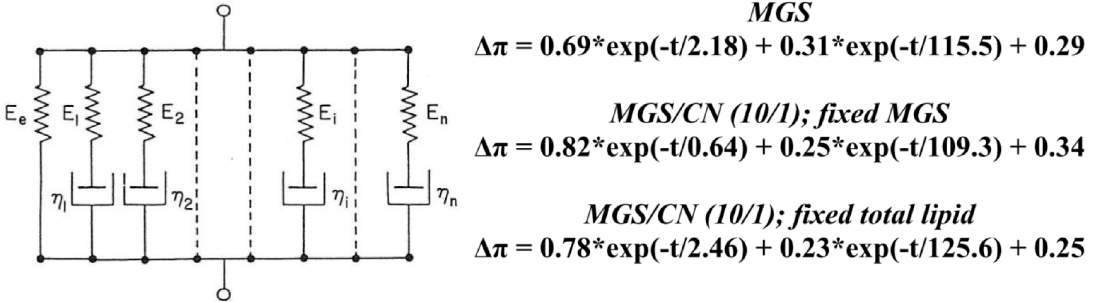
Figure 9. Maxwell models fit (Equation (2)) of the data presented at Figure 6.